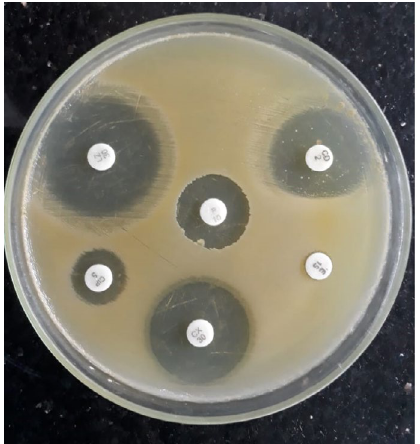
Fig. 1. Showing Positive